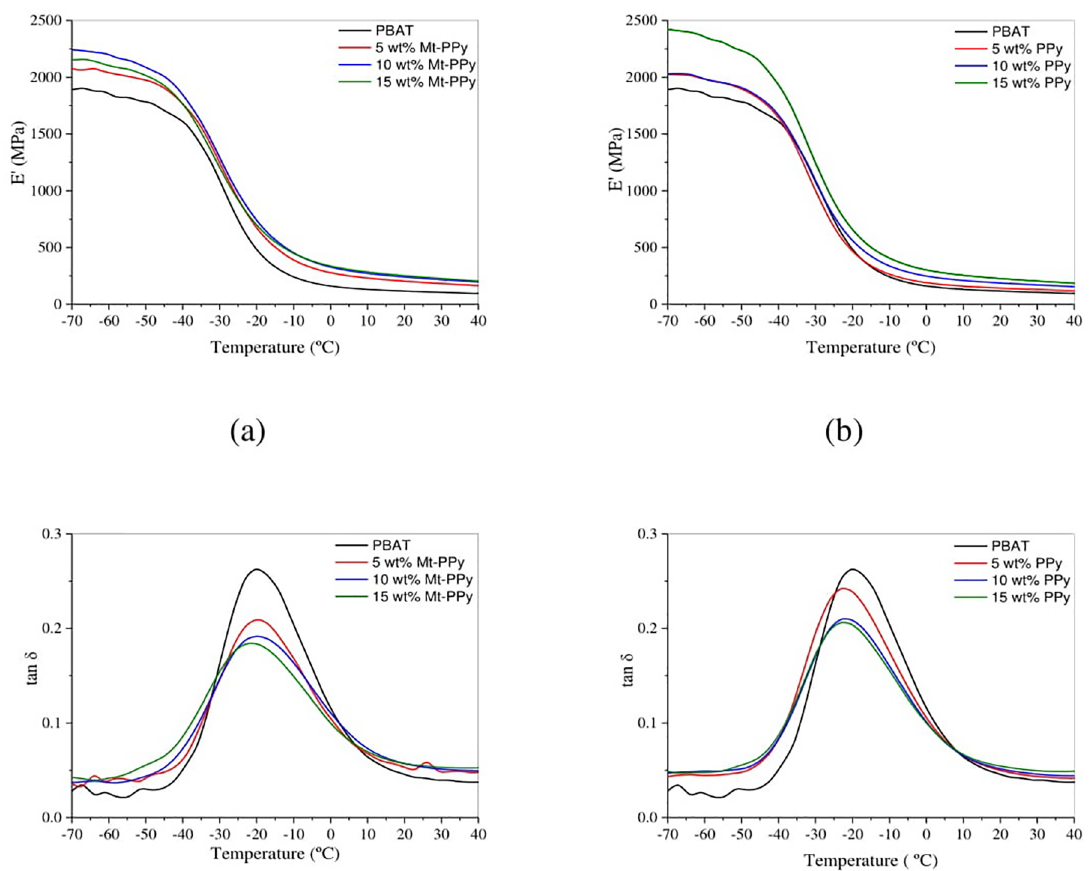
Figure 6. Storage modulus (a,b) and loss tangent (c,d) of neat PBAT, PBAT/Mt-PPy and PBAT/PPy.